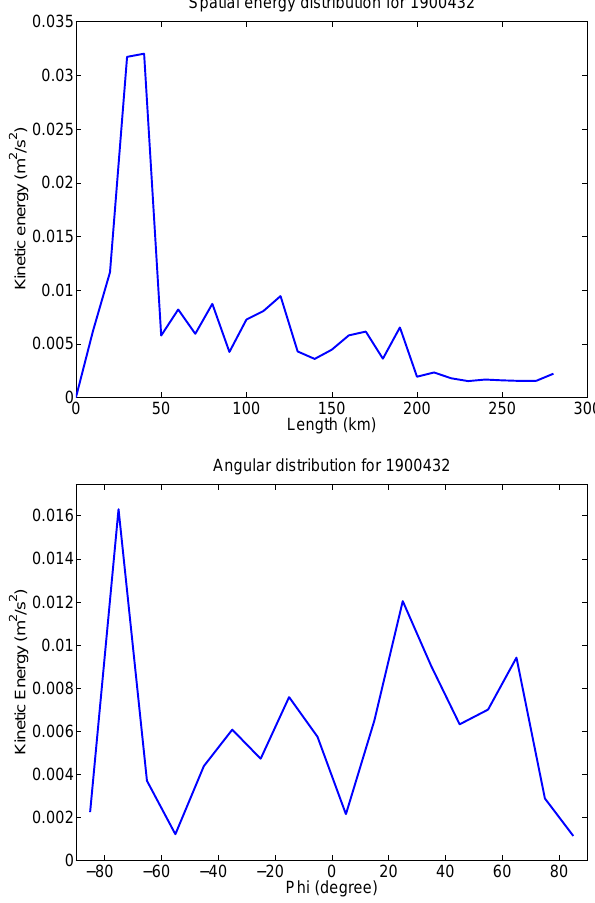
Fig. 3. Distribution of Lagrangian kinetic energy (in m 2 s 2 ) with Figure 3: Distribution of Lagrangian kinetic energy (in m 2 /s 2 ) with respect to horizon- 10 tal displacement (top) and to the orientation of the displacement (bottom), for float respect to horizontal displacement (top) and to the orientation of 1900432 the displacement (bottom), for float